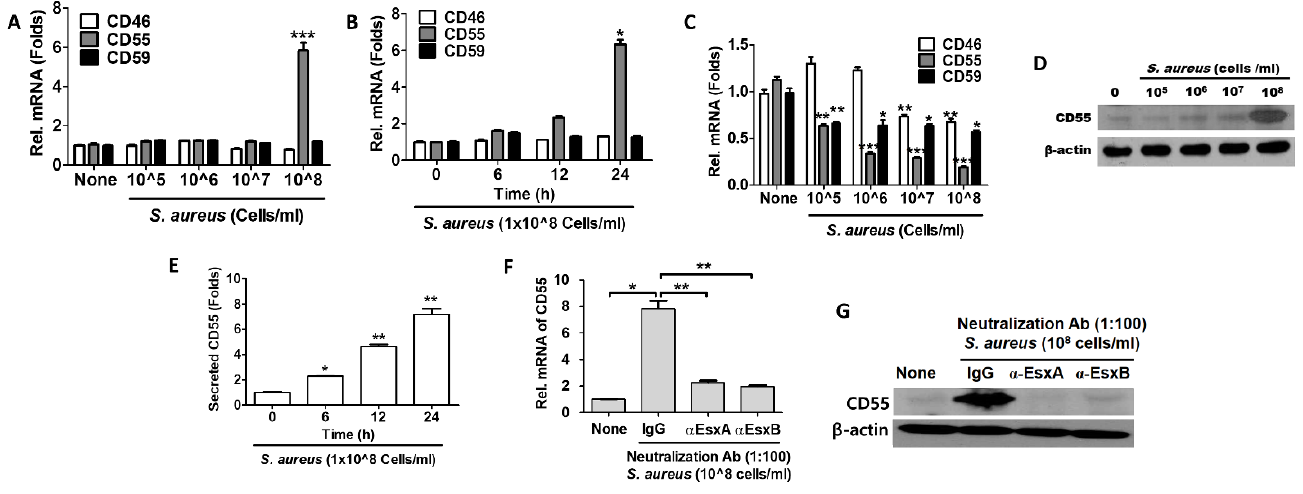
Figure 2. Decay-accelerating factor (CD55) was increased by S. aureus infection. HaCaT cells were treated with the indicated doses of S. aureus ( A ) for 24 h or with 1 × 10 8 CFU/mL of S. aureus for the indicated times ( B ). In an alternative experiment, HaCaT cells were treated with heat-killed S. aureus for 24 h ( C ). The mRNA expression of CIP was examined by real-time PCR and normalized to that of glyceraldehyde 3-phosphate dehydrogenase (GAPDH). ( D ) The CD55 protein level was examined via Western blotting after S. aureus treatment. ( E ) Secreted CD55 was examined using indirect ELISA from the culture supernatants of HaCaT cells treated with S. aureus . The CD55 mRNA levels ( F ) and protein levels ( G ) of HaCaT cells pretreated with neutralization antibodies and then treated with S. aureus were examined by real-time PCR. The data displayed are the mean ± SD of three independent experiments. Statistical analysis was conducted with a one-way ANOVA. * p < 0.05, ** p < 0.01, *** p < 0.001 vs. 0 or None.